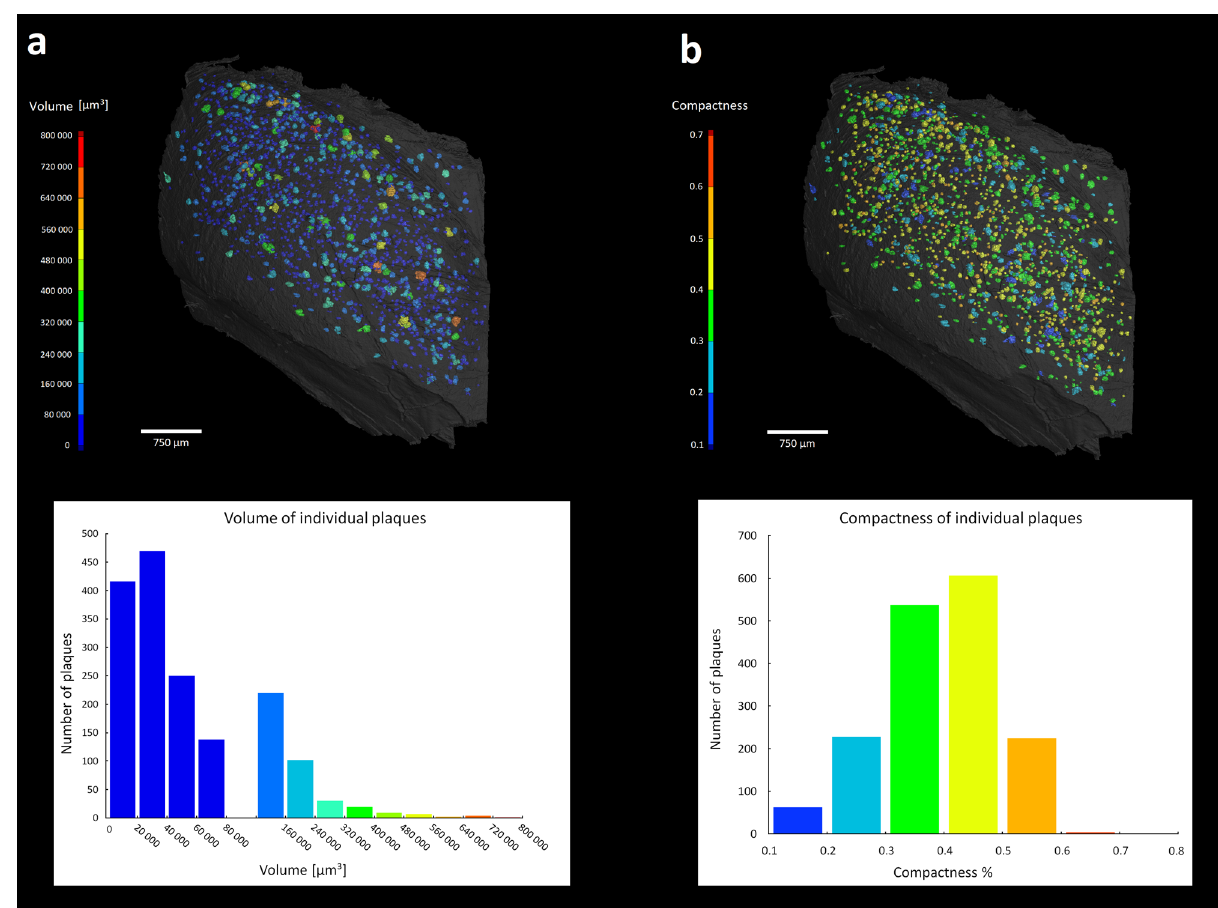
Figure 4. 3D quantitative analysis of the Aβ plaques size and shape in hippocampus: Panel ( a ) shows the plaques 3D distribution color coded respective to their size, with the corresponding histogram in the same color scale on the right. Panel ( b ) illustrates the same plaques color scaled according their compactness (red codes for higher similarity to a sphere) with the respective histogram (right) 41,42